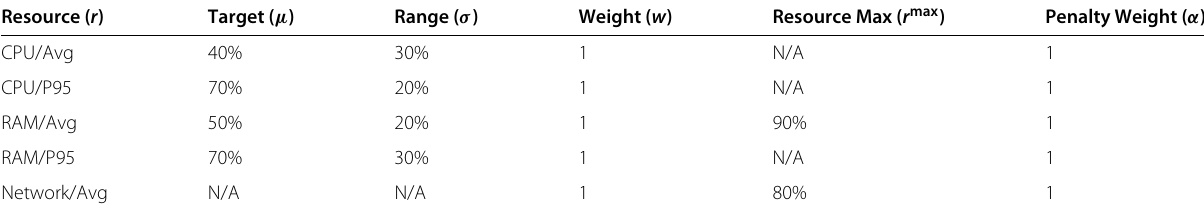
Table 1 Parameters used in the experiments and validation Resource ( r )